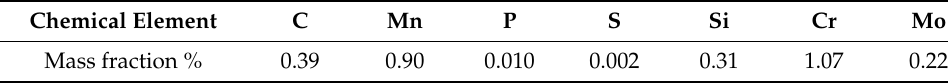
Figure 2. Manufacturing process. Table 1. The chemical composition of SA-372 Grade J.